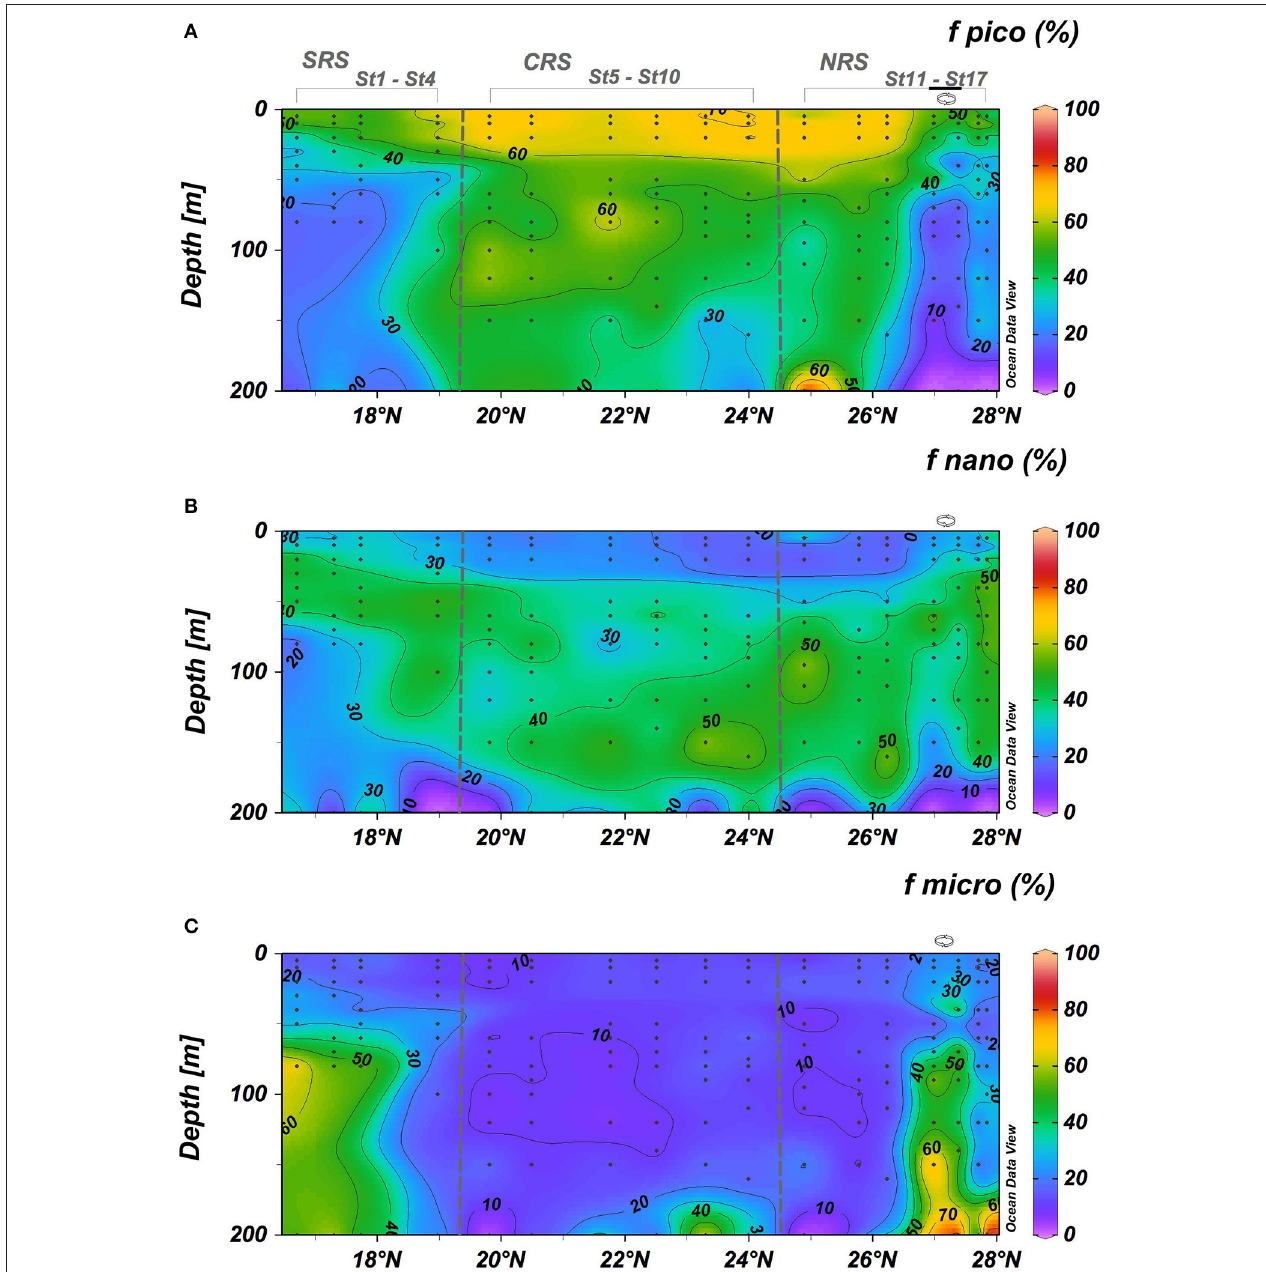
FIGURE 6 | Vertical cross percentages (A–C) associated to the pico-, nano-, and micro-phytoplankton groups. Black dots represent sampling points. Eddy stations marked along the top of the upper graph.